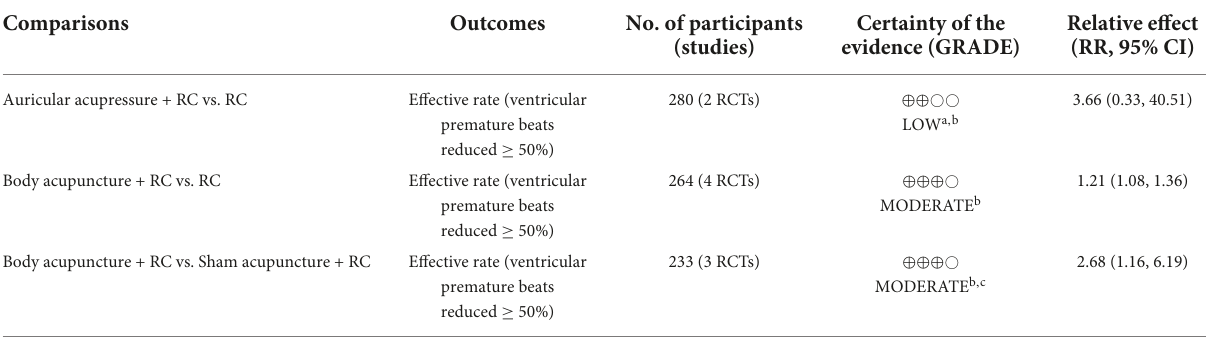
TABLE 3 Summary of